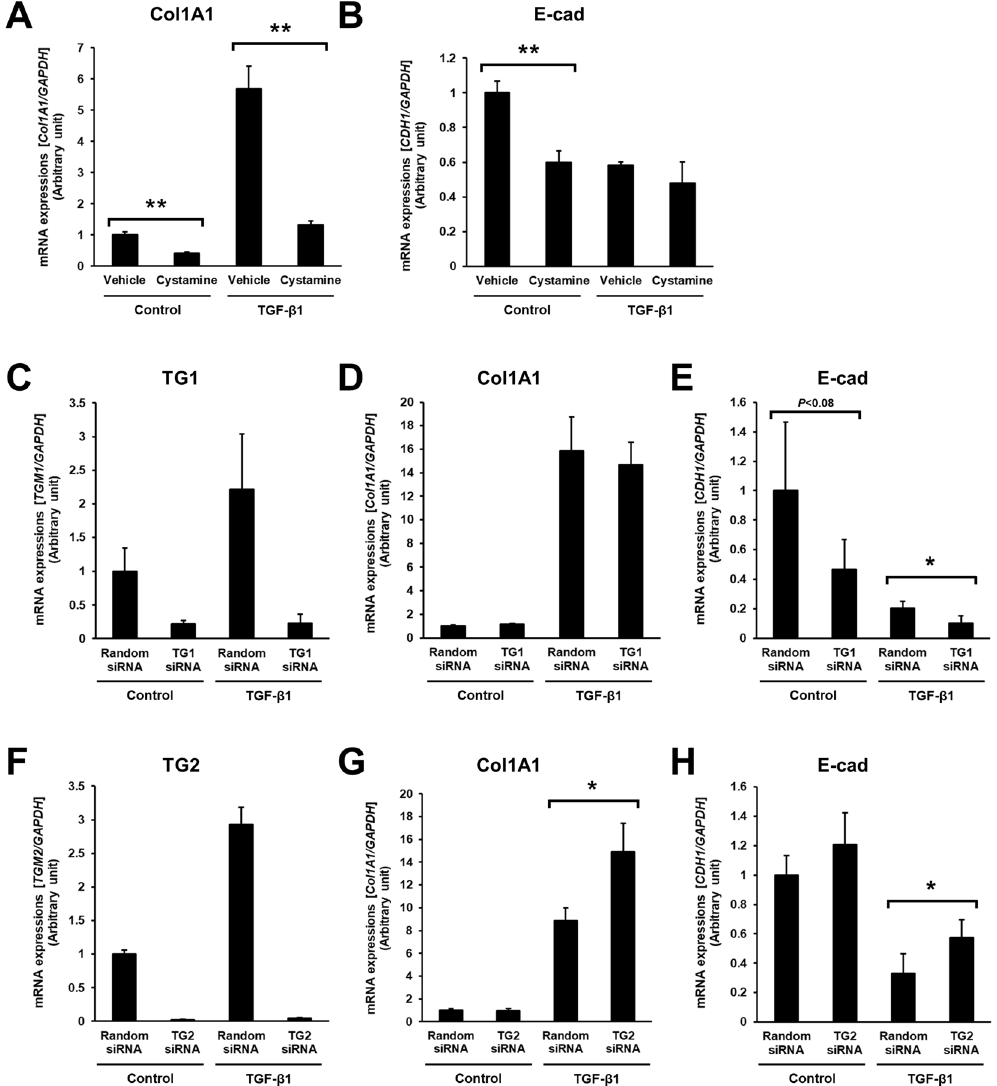
Figure 6. The effect of TGs inhibitor or knockdown of TG1 and TG2 in renal tubular epithelial cells. ( A,B ) Human tubular epithelial cells (HK-2) were plated in 6 cm dish (3 × 10 5 cells) and treated with 5 ng/ml TGF- β 1 in the presence or absence of 1 mM cystamine in serum-free medium for 12 h. ( C–H ) For the knockdown of specific gene, siRNA mixture against TG1 ( C–E ) or TG2 ( F–H ) were added on the culture dish before seeding the cells. As a negative control, scrambled siRNA (Random) was replaced with the same amount of siRNA against TG1 and TG2. Then, after 24 h incubation, cells were treated with TGF- β 1 for 12 h. Total mRNA were isolated and the indicated mRNA levels were evaluated using quantitative RT-PCR. Data were normalized against GAPDH mRNA expression and relative value (a ratio of the control sample) were presented as the mean ± SD ( n = 3) ( ** P < 0.01, * P < 0.05, Student’s t